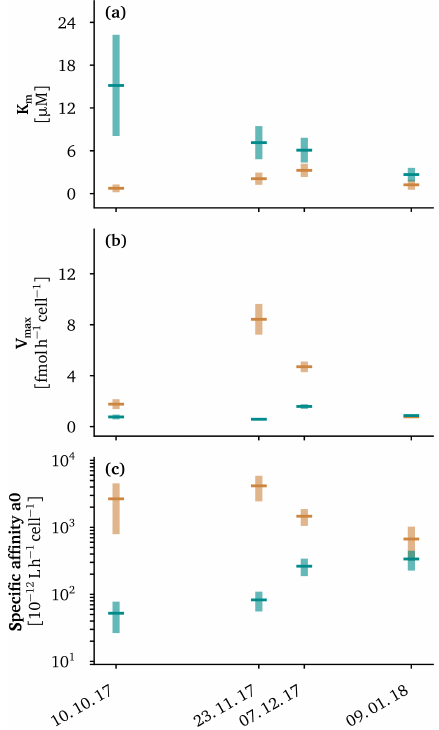
Figure 2. Apparent kinetic properties of the methanotroph assem- blage above (orange) and below (cyan) the oxycline for the four sampling campaigns at in situ temperatures of the oxycline. We plot 95% confidence intervals as light cyan and light orange ver- tical bars. Average values are plotted as dark green and dark or- ange lines. The methane oxidation half-saturation constants ( K m ) are displayed in (a) , the maximum cell-specific methane oxidation rates are shown in (b) and the specific affinities, defined as the ratio V max /K m , are given in (c)